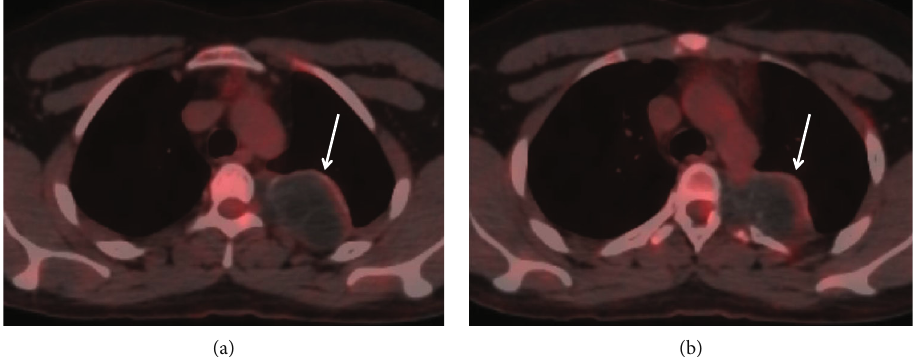
Figure 2: Axial fused PET/CT images (a, b) show a well-de fi ne left paravertebral cystic mass and heterogeneous cystic mass with no signi fi cant FDG uptake.